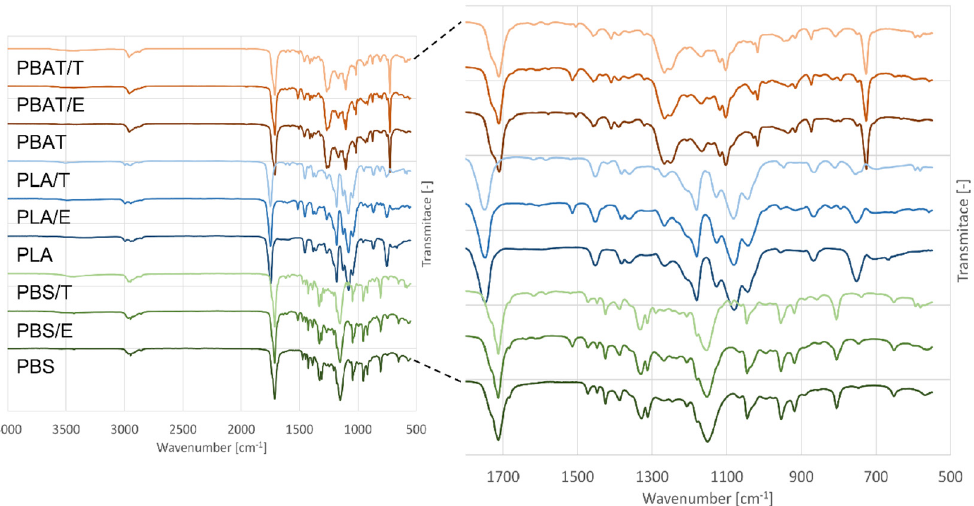
Figure 2. The FTIR spectra of pure and modified polymers; PLA: poly(lactic) acid, PBAT: poly(butylene adipate-co-terephthalate), PBS: poly(butylene succinate), E: 3% w / v eugenol, T: 3% w / v thymol.